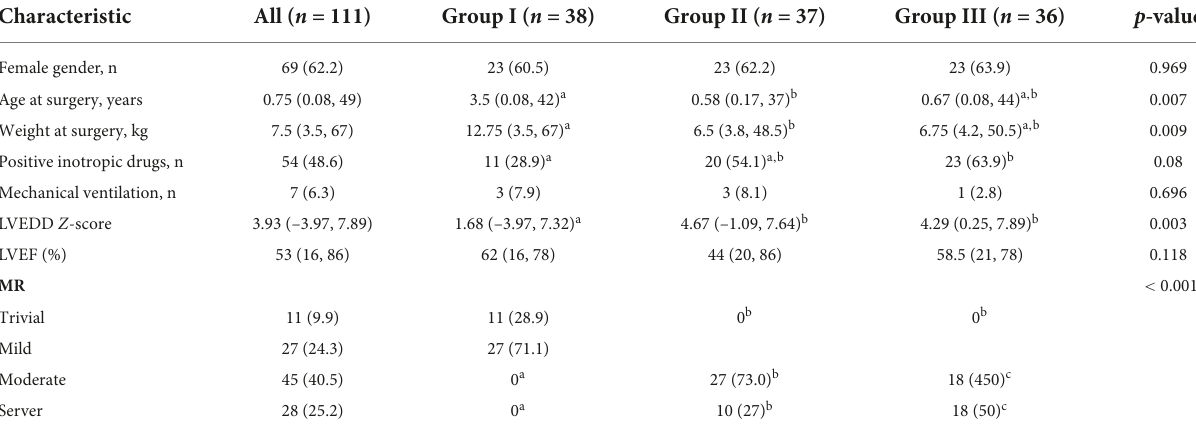
TABLE 2 The preoperative characteristics of all patients.